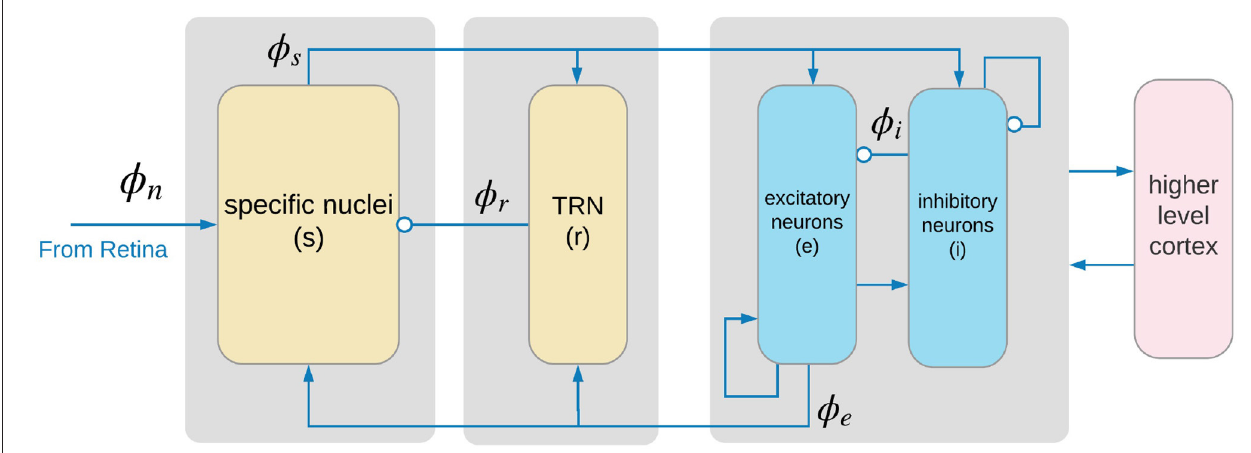
FIGURE 1 | Physiologically based corticothalamic model in which the arrows represent excitatory effects and the circles depict inhibitory ones. The populations are cortical excitatory ( e ) and inhibitory ( i ) neurons, the thalamic reticular nucleus ( r ), thalamic relay neurons ( s ) that project to the cortex, and non-corticothalamic neurons responsible for external inputs ( n ). Gray boxes depict the lateral geniculate nucleus (LGN) (left), the thalamic reticular nucleus (TRN) (middle), and primary visual cortex (right).